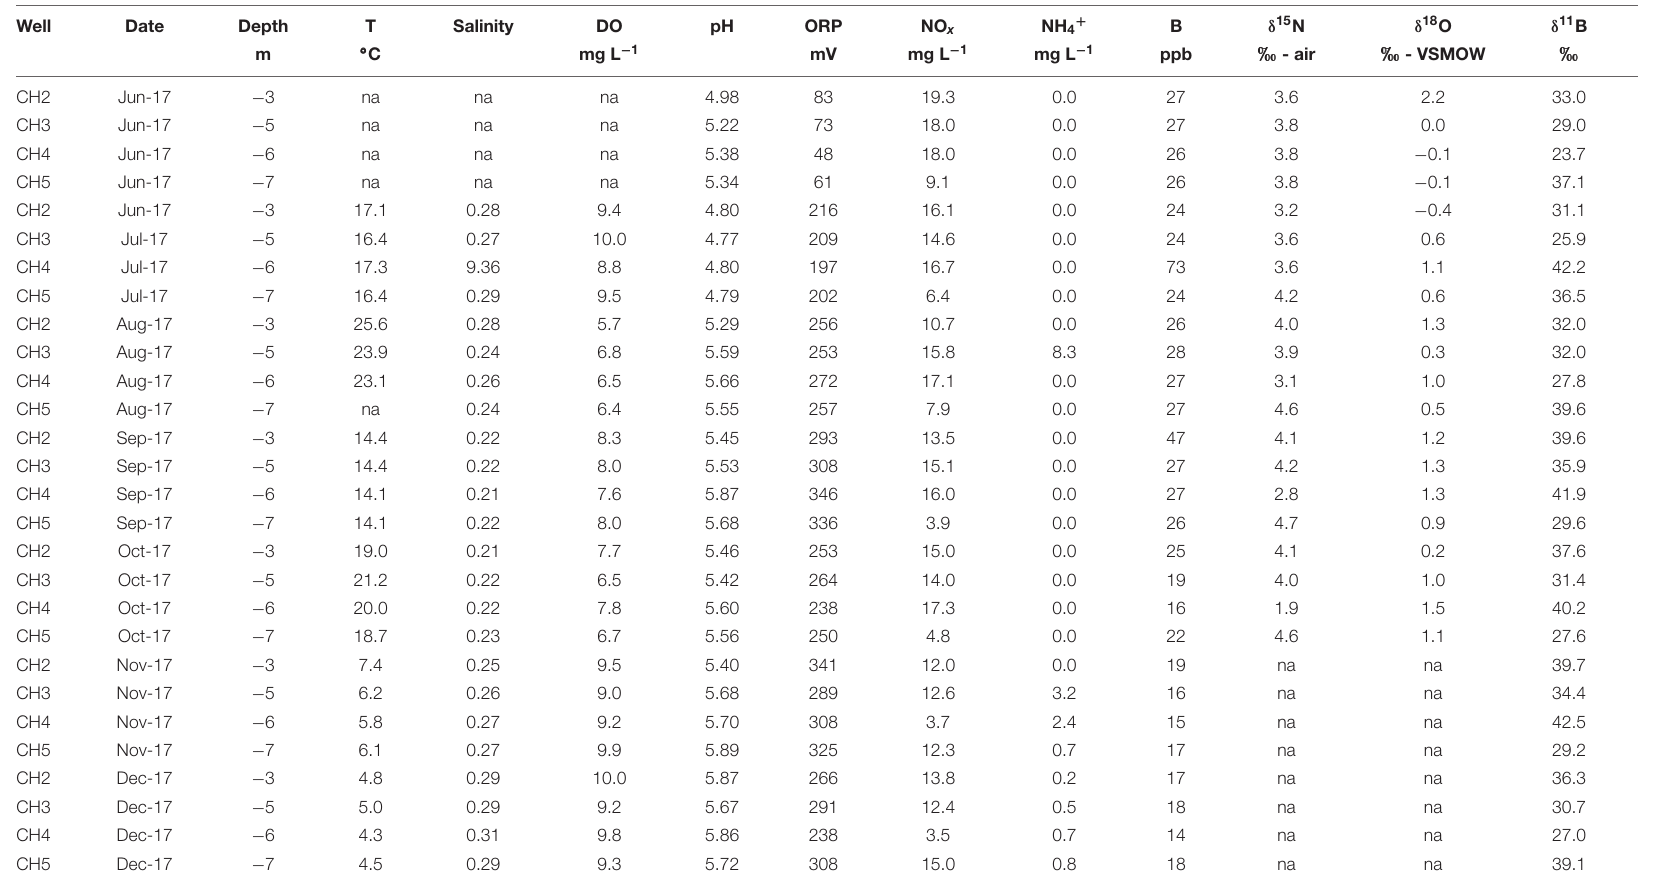
TABLE 3 | Callahans Beach coastal groundwater samples collected in 2017.